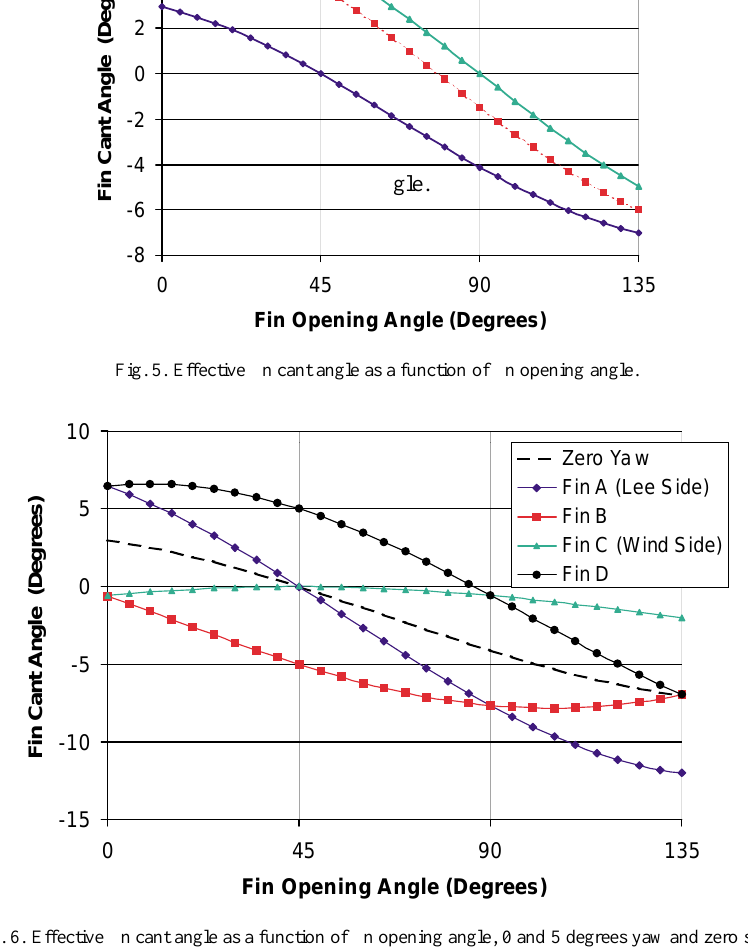
Fig. 6. Effective fin cant angle as a function of fin opening angle, 0 and 5 degrees yaw and zero